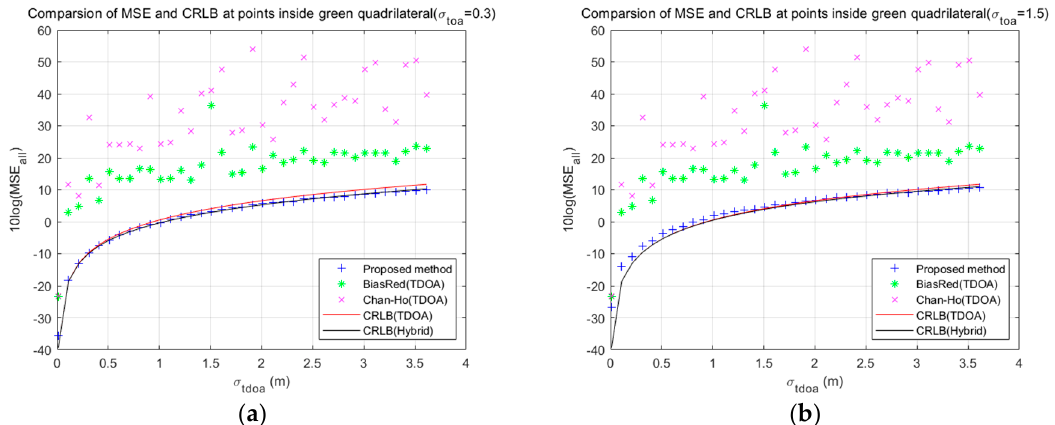
Figure 13. Accuracy of different positioning method at points inside green quadrilateral; ( a ) positioning error MSE when the standard deviation of TOA ranging error is 0.3 m; ( b ) positioning error MSE when the standard deviation of TOA ranging error is 1.5 m.